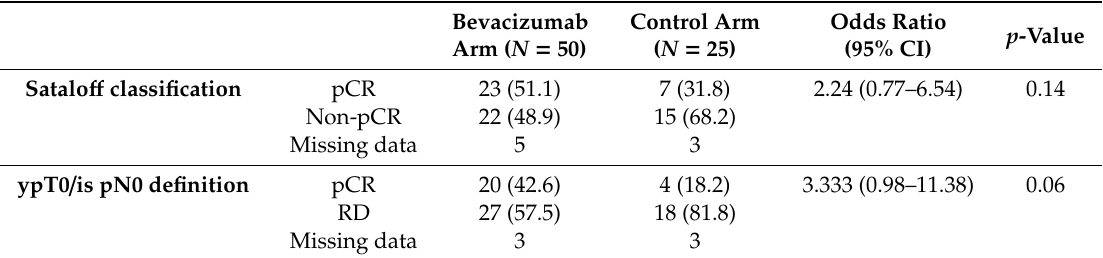
Table 3. Pathological response rates. Results are notified as N (% of cases with data